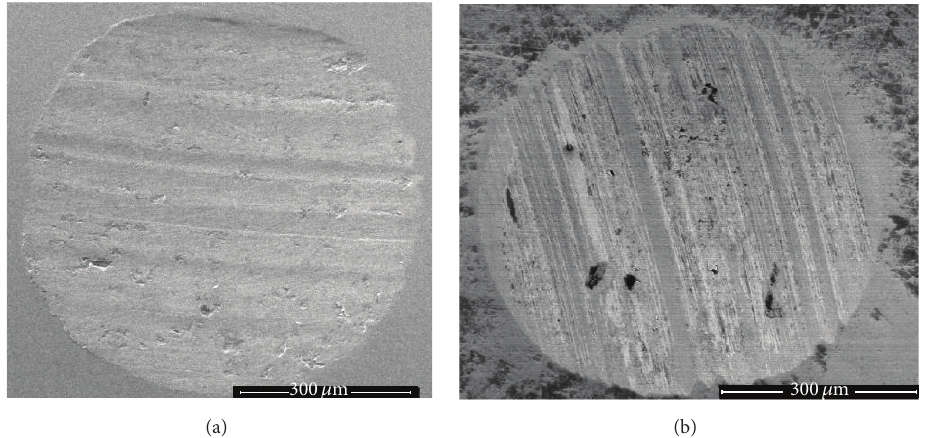
Figure 7: SEM images of ball after 2 hr test (a) ball run on Oil A and (b) ball run on Oil